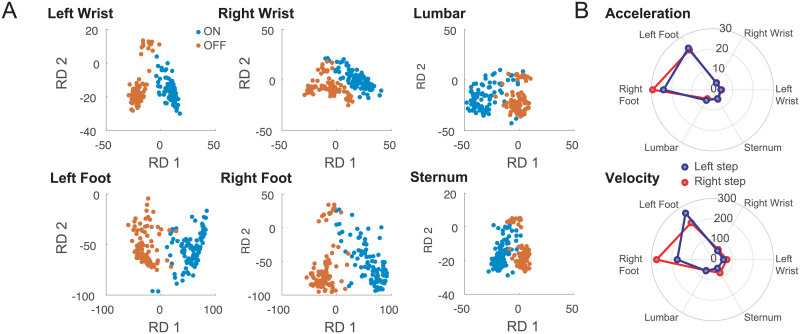
Discrimination of ON versus OFF states.A–Example of projecting acceleration data for each body part in both medication states (ON in blue and OFF in orange) using participant-specific templates. B–Mean population differences of ON vs. OFF medication states by sensor position triggered either by left (red) or right step (blue). The same analysis was repeated both for acceleration (upper) and velocity (lower) signals.